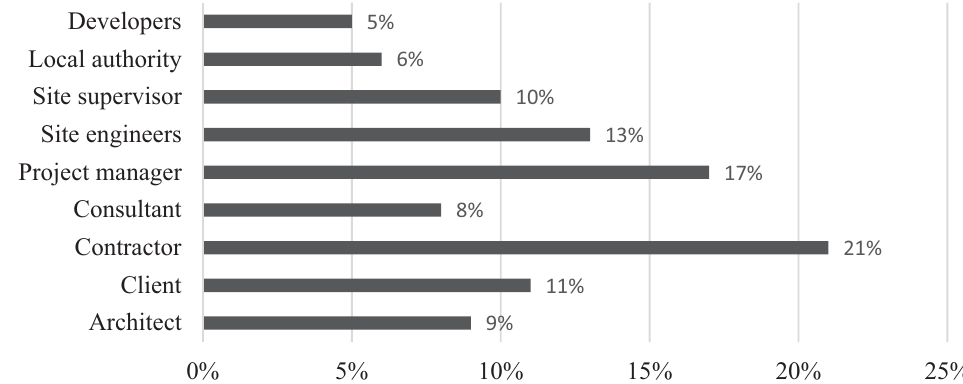
Figure 3. Professions are believed to be the most responsible for emissions management in construction